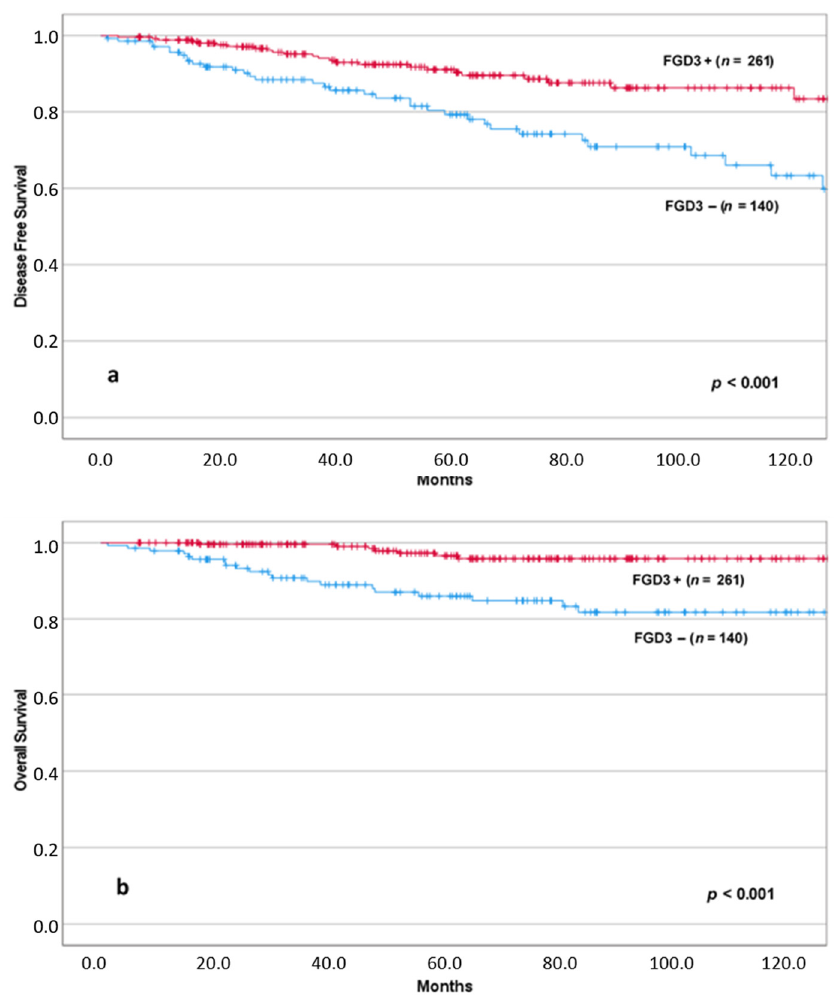
Figure 2. DFS ( a ) and OS ( b ) according to FGD3 expression.